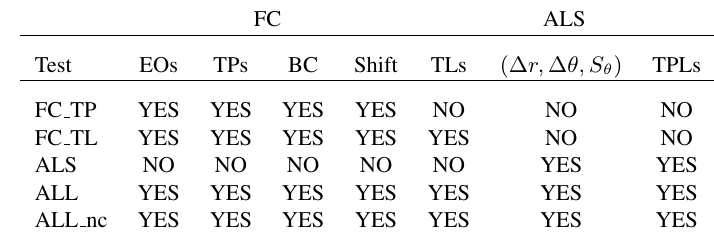
Table 7: Estimated parameters of block configurations.